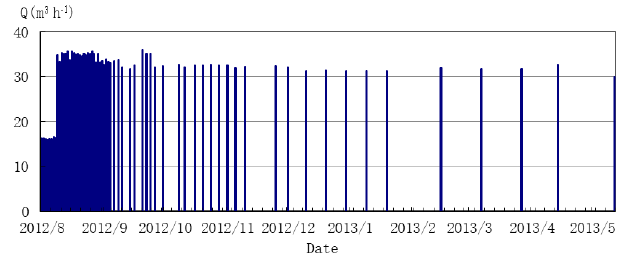
Figure 3. Rate of injection curve in the testing site.